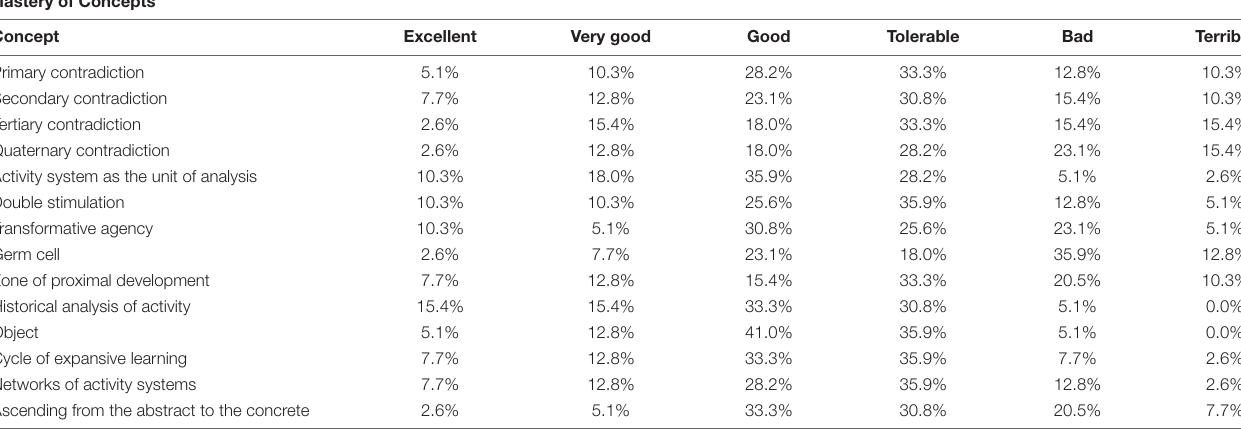
TABLE 2 | Mastery of the Cultural-Historical Activity Theory and Change Laboratory concepts. Mastery of